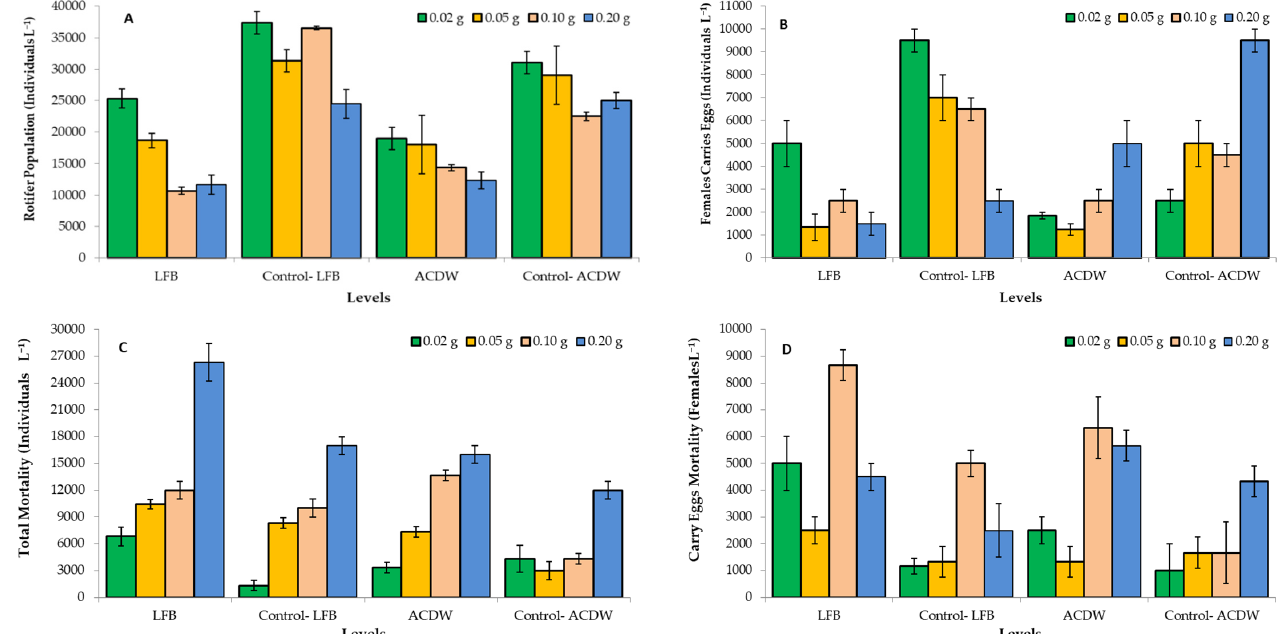
Figure 14. Effect of different levels of Arthrospira platensis NIOF17/003 complete dry weight (ACDB) and free lipid (LFB) which was loaded by dye (Ismate violet 2R, IV2R) removed from industrial textile effluents, on rotifer Brachionus plicatilis population ( A ), female carry eggs population ( B ), and total rotifer mortality ( C ), and female carry eggs mortality ( D